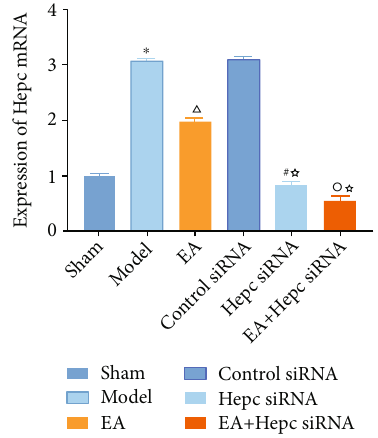
Figure 5: RT-PCR results of Hepc